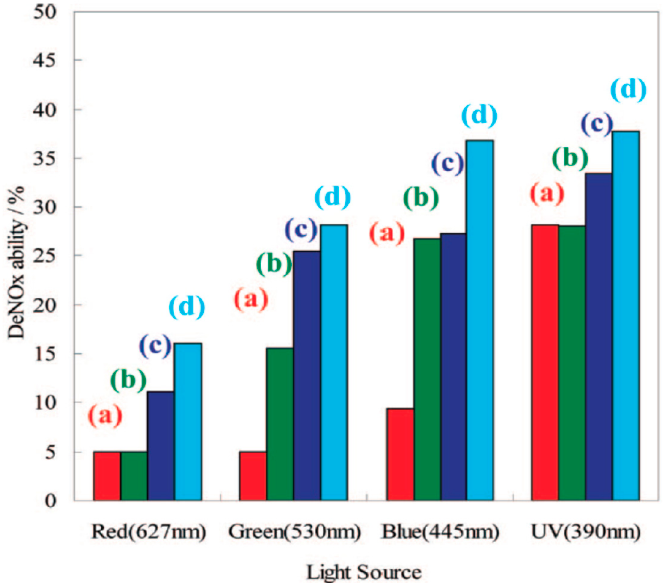
Figure 26. Photocatalytic deNO x abilities of samples under irradiation by various LED light sources: (a) S-TiO 2 ; (b) TiON; (c) TiONFe; and (d) TiONPt. Reproduced with permission from Yin et al. [111]. Copyright 2008 by the American Chemical Society.